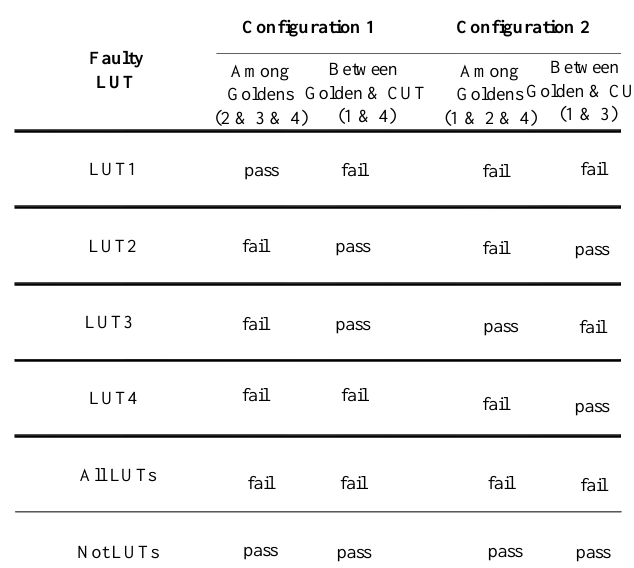
Table 1. Diagnosing faulty LUTs.